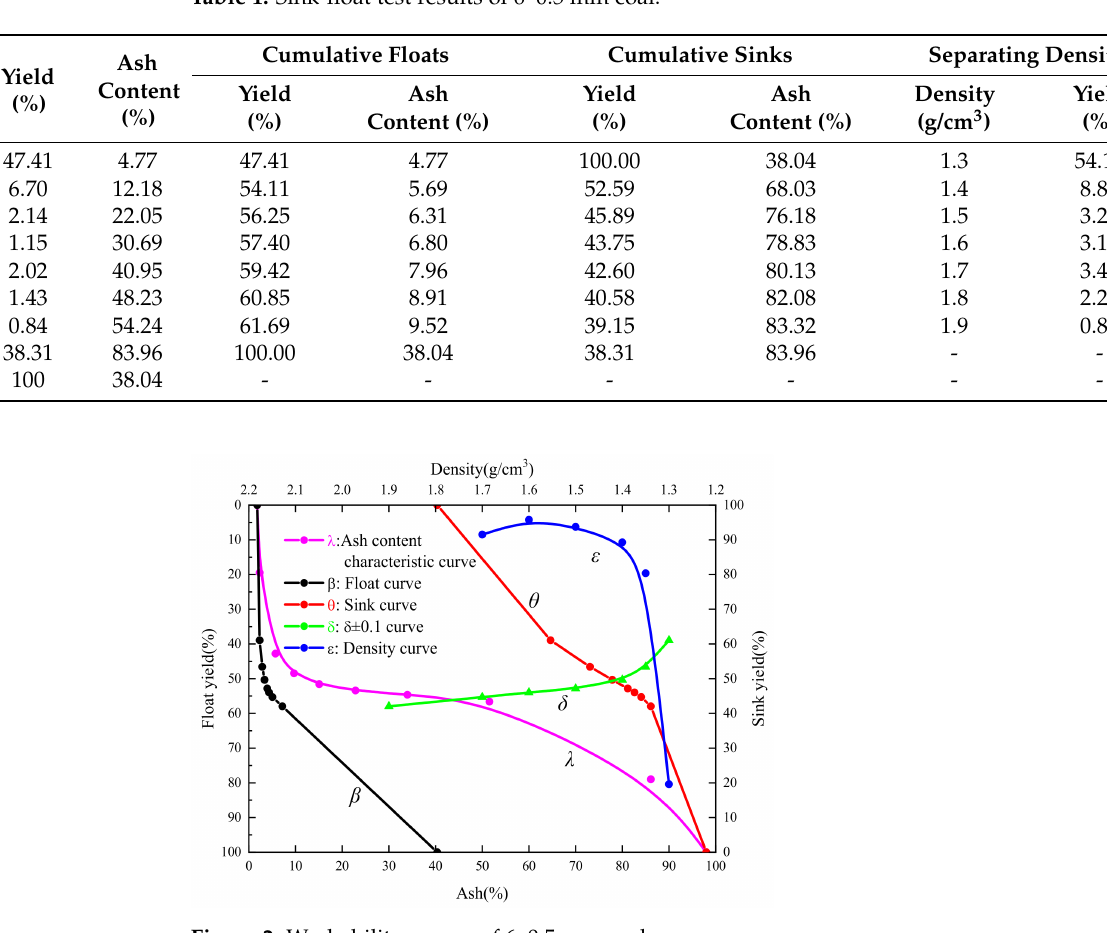
Figure 1. Particle size distribution of raw coal. Table 1. Sink-float test results of 6–0.5 mm coal.